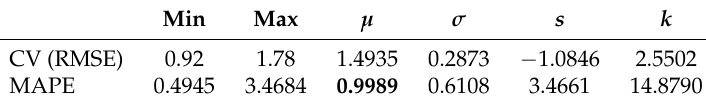
Table 5. Statistical indicators for relative performance metrics, CV (RMSE) and